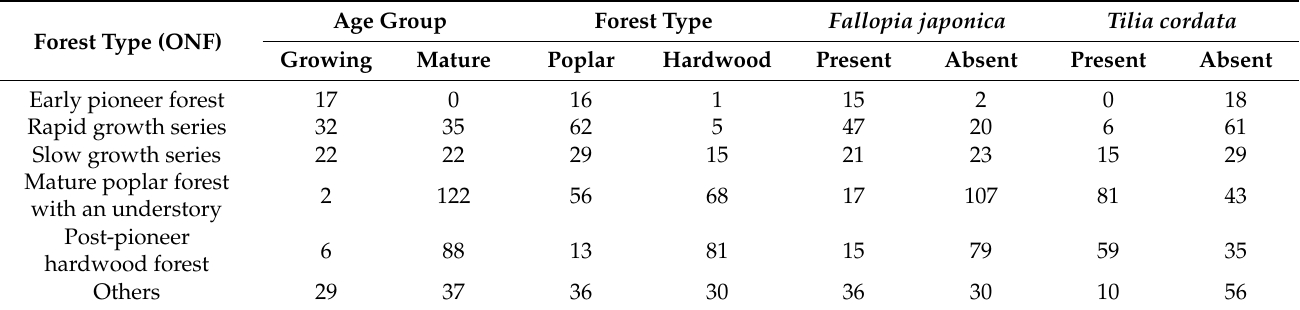
Table 9. Forest type of each vegetation plot according to the ONF survey and the number of plots of each type classified in each class of the four random forest